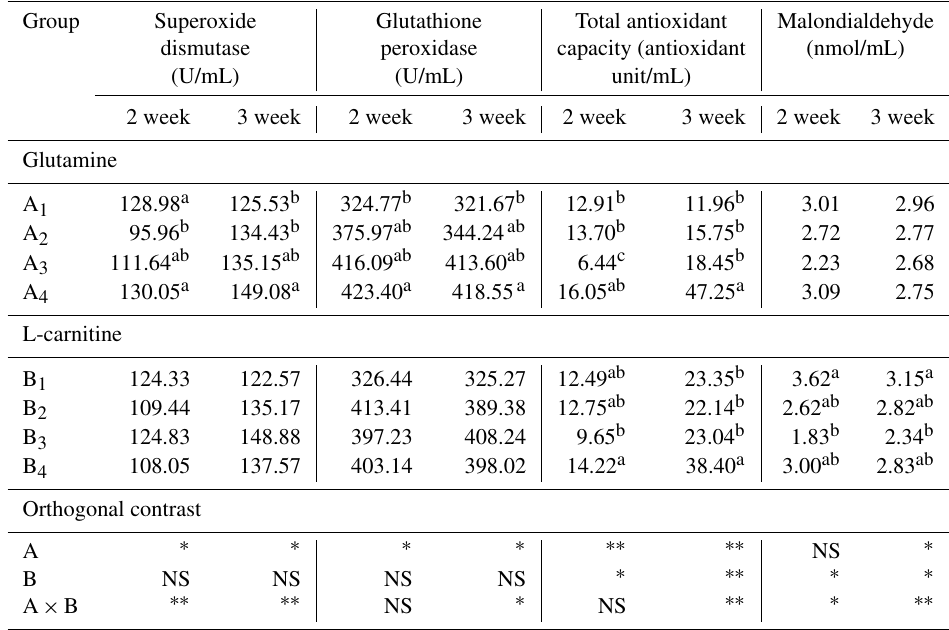
Table 9. The effects of supplemented glutamine and L-carnitine on antioxidant capacity of Arbor Acres broilers under low temperature